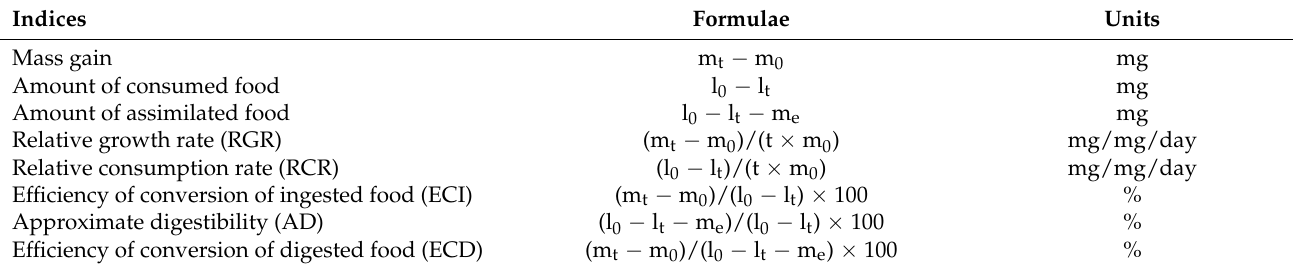
Table 1. Formulae for growth and nutritional